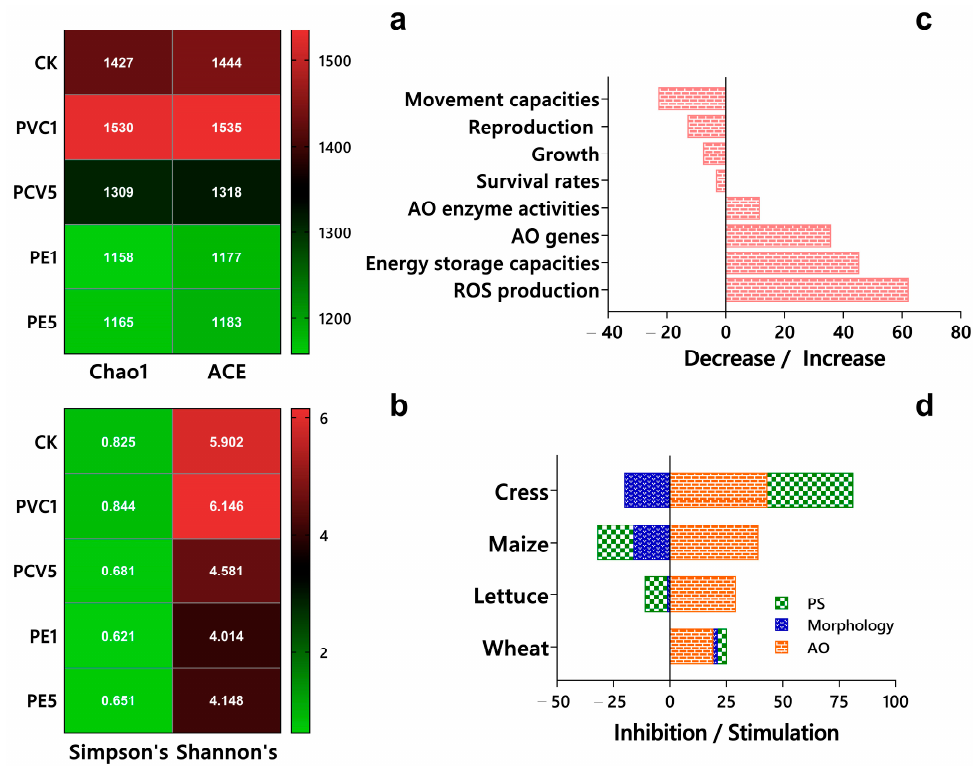
Figure 4. Response of microorganisms, plants, and animals to MPs/NPs in farmland soils. ( a ) Community richness (Chao1 and ACE), and ( b ) Community diversity (Simpson’s and Shannon’s) of bacteria as affected by MPs in soil (based on data from Fei et al. [168]). CK—control soil, PVC1—polyvinyl chloride 1% ( w / w ), PVC5—polyvinyl chloride 5% ( w / w ), PE1—polyethylene 1% ( w / w ), PE5—polyethylene 5% ( w / w ). ( c ) Response of animal functions to MPs in soil, as indicated by meta ‐ analysis [211] (AO—antioxidant, ROS—Reactive oxygen species). ( d ) Impact of MPs on specific functions in different plant species. Per cent values of change were transformed from RR (risk ratio) of meta ‐ analysis data [212], (PS—Photosynthesis, AO—Antioxidant system).